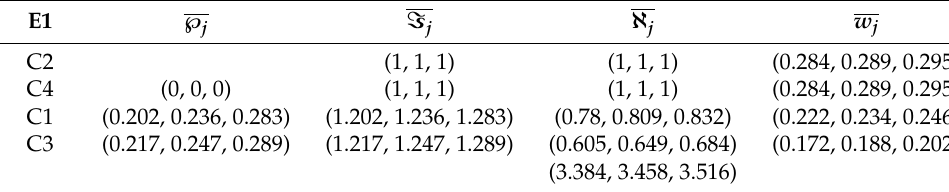
Table 4. Calculation of criterion weights by IMF SWARA-Z method for